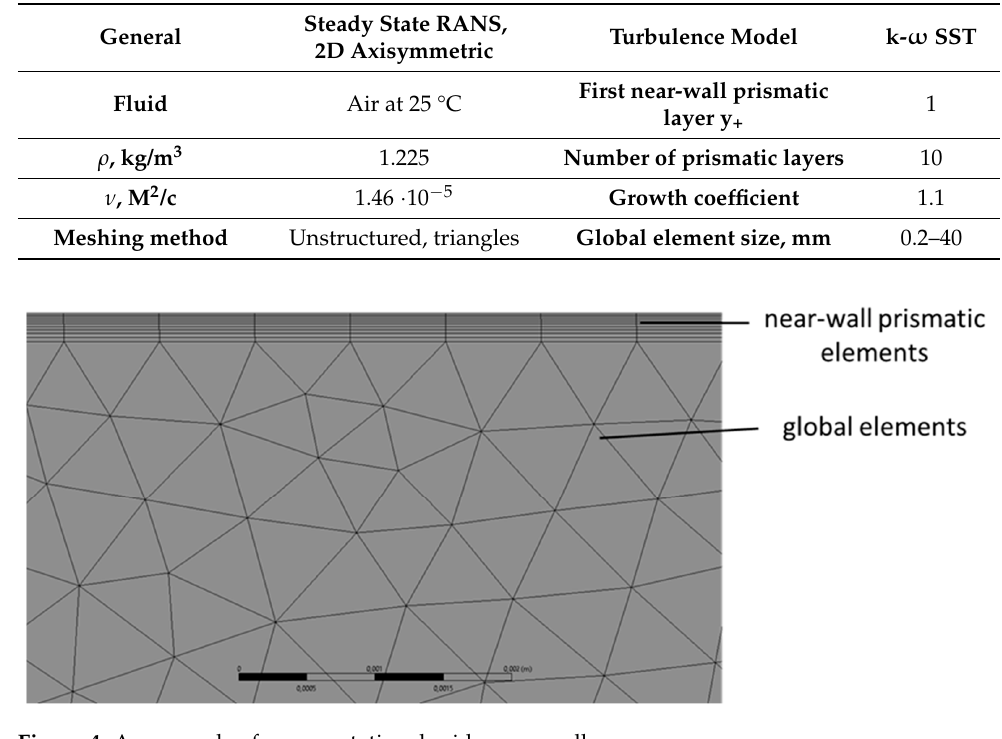
Figure 4. An example of a computational grid near a wall.